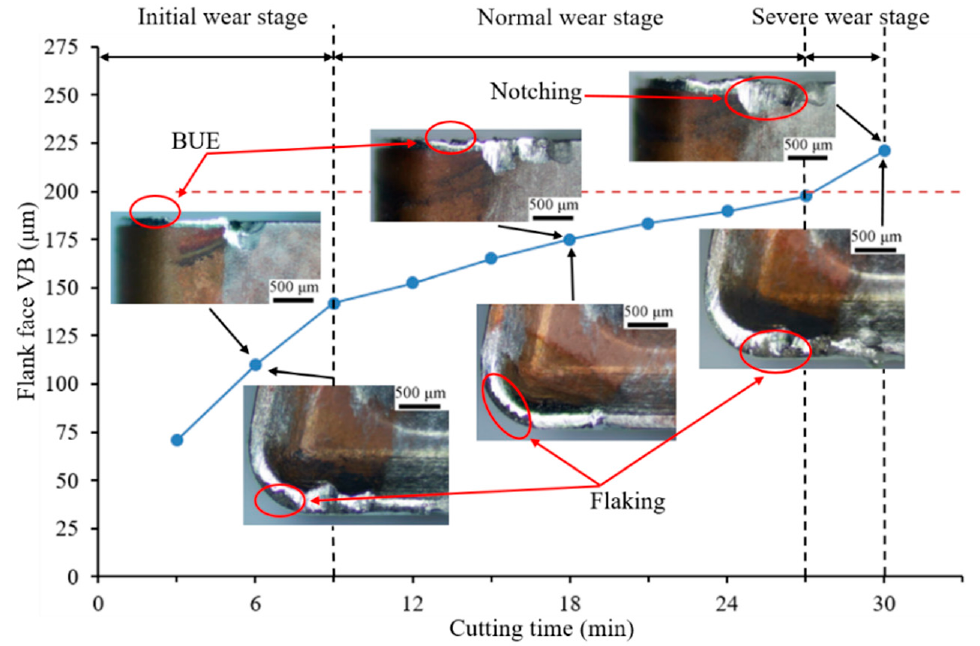
Figure 5. Tool wear evolution of Tool 1 on rake and flank faces ( mm/r).